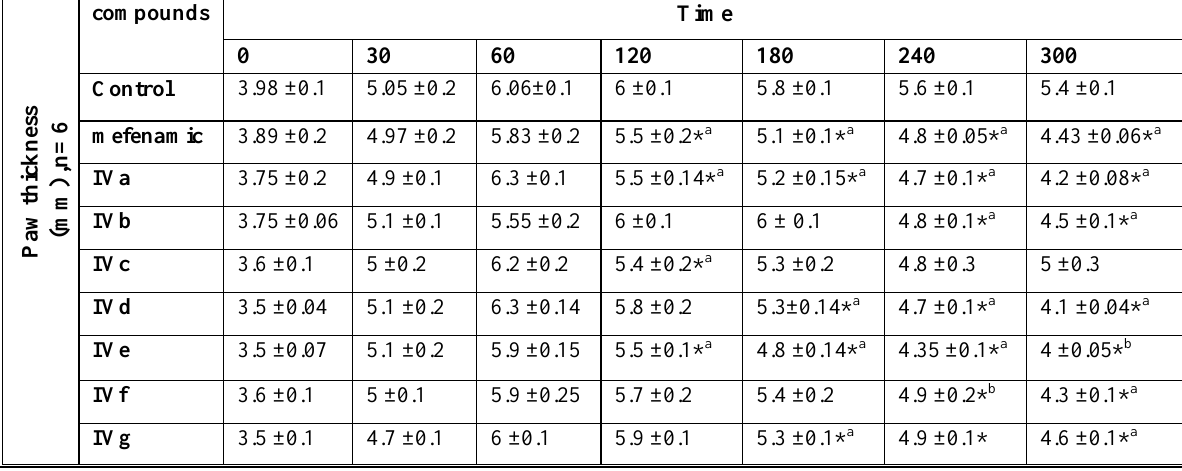
Table (4) The anti-inflammatory effect of control, mefenamic acid and compounds IVa-g on egg-white induced paw edema in